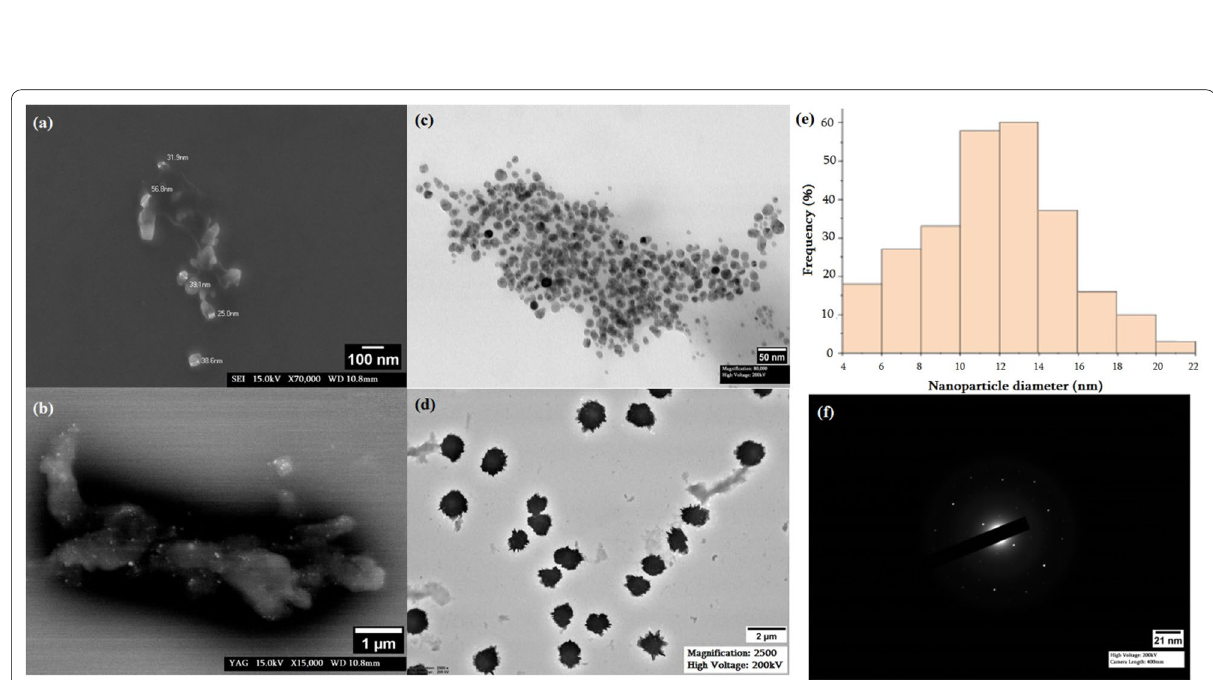
Fig. 4 SEM ( a , b ), TEM ( c , d ) micrographs and nanoparticle diameter distribution ( e ) and SAED pattern ( f